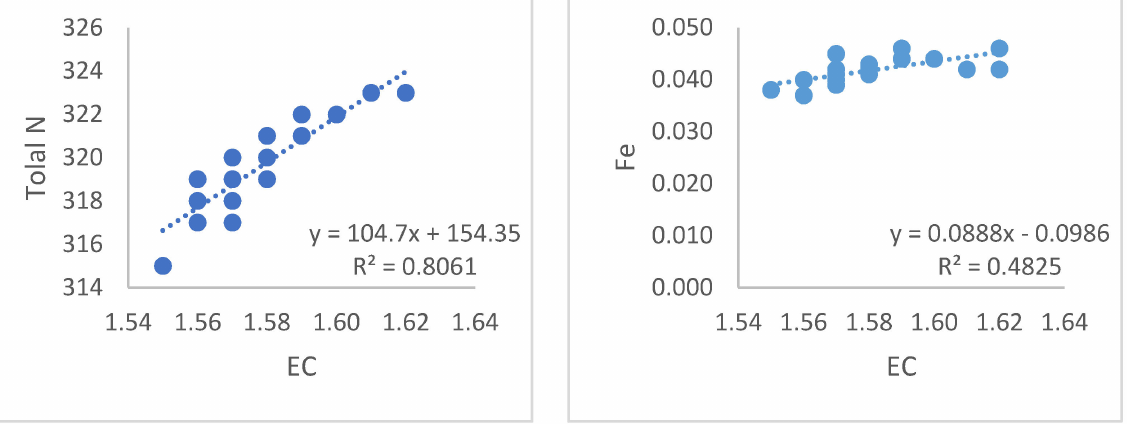
Figure 6. Relationships between the EC values of the liquid in the system and the total N and Fe